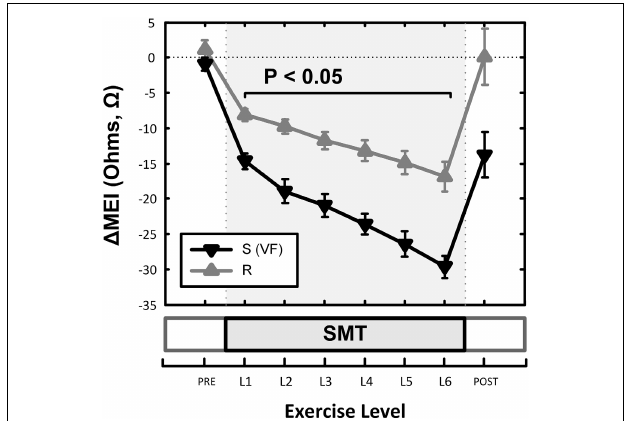
FIGURE 7 | Effects of underlying arrhythmic susceptibility of each animal in the myocardial electrical impedance (MEI) response to exercise; animals prone to ischemia-induced VF (i.e., S; n = 12) had a significantly larger MEI response to submaximal exercise, when compared those that were resistant (i.e., R; n = 9).